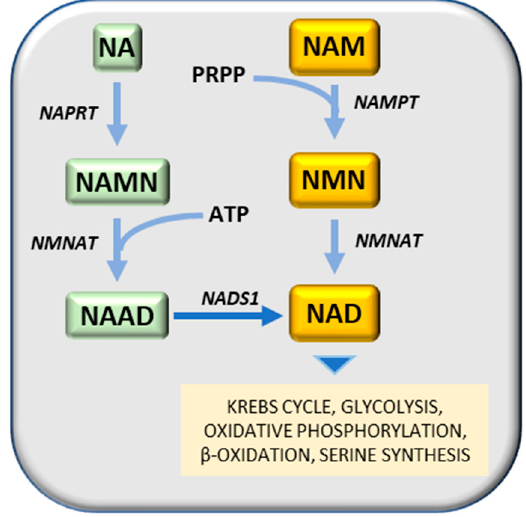
Figure 8. NAD synthesis. Substrates: NA, nicotinic acid; NAD, Nicotinamide adenine dinucleotide; NAAD, nicotinic acid adenine dinucleotide; NAM, nicotinamide; NAMN, nicotinic acid mononucleotide; NMN, nicotinamide mononucleotide; PRFPP, 5-phosphoribose-1-pyrophosphate. Enzymes: NADS1, NAD synthetase; NAMPT, nicotinamide phosphoribosyltransferase; NMNAT, nicotinamide mononucleotide adenylyltransferase; NAPRT, nicotinic acid phosphoribosyltransferase.